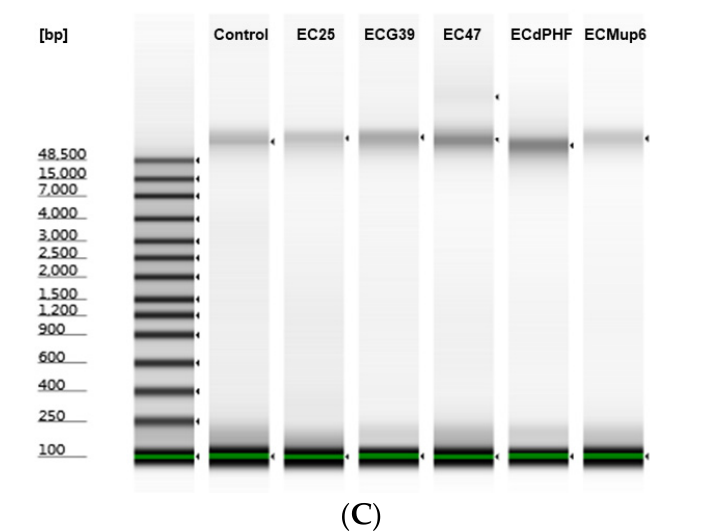
Figure 2. Effect of eDNA and RNA of different Escherichia coli strains on amyloid β (A β ) aggregation. To study the effect of DNA on A β aggregation, A β 1-42 oligomers were incubated with preparations containing 1000 ng of nucleic acids extracted from different strains of E. coli . eDNA of E. coli ATCC29522 (EC25), E. coli ATCC472217 (EC47), E. coli G39 (ECG39), E. coli dPHF (ECdPHF), and E. coli MUP6 (ECMup6), RNA of E. coli ATCC29522 (EC25_RNA), and eDNA of E. coli ATCC29522 treated with DNase (EC25+DNase) were used. ( A ). ThT fluorescence as a function of time in the presence of indicated DNA and RNA probes (h); ( B ) t1/2 values of aggregation. Values